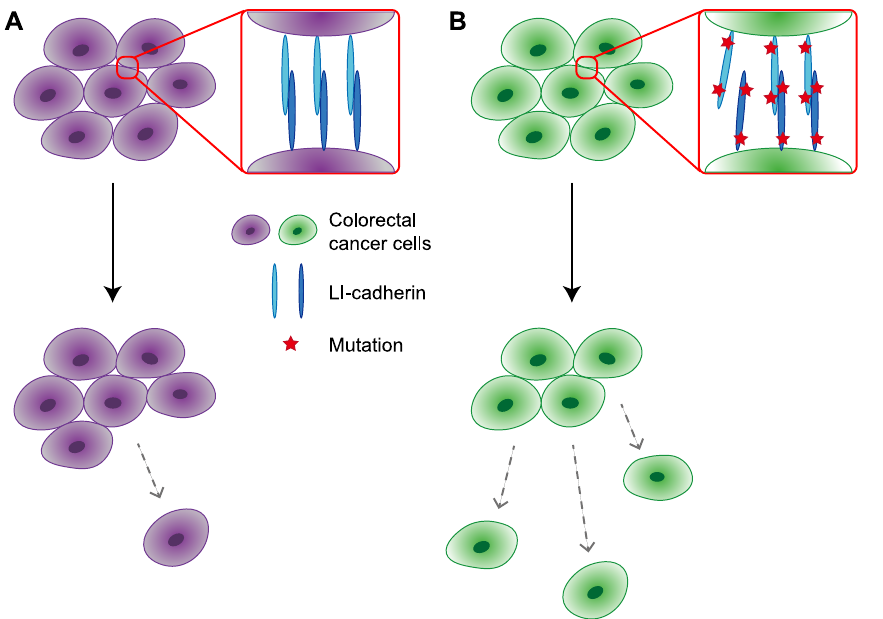
Figure 7. Possible mechanisms of increased lymph node metastasis of colorectal cancer associated with single nucleotide polymorphisms (SNPs) in LI-cadherin-coding gene. ( A ) Patients without SNPs. ( B ) Patients with